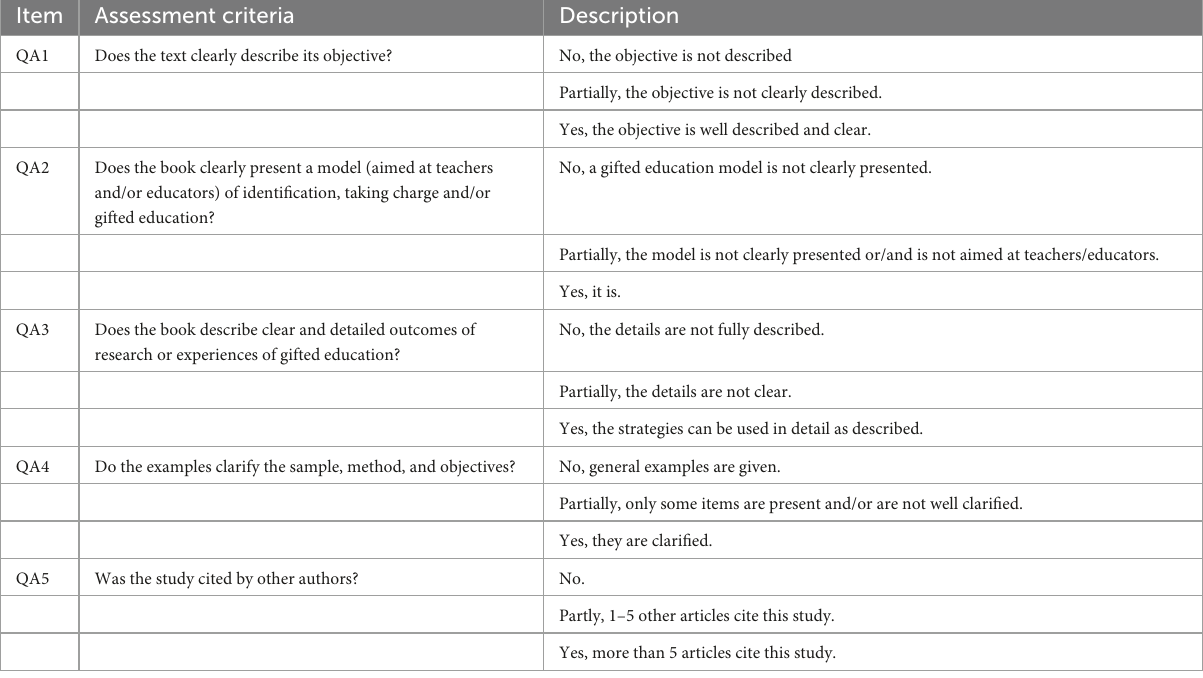
TABLE 4 Quality assessment